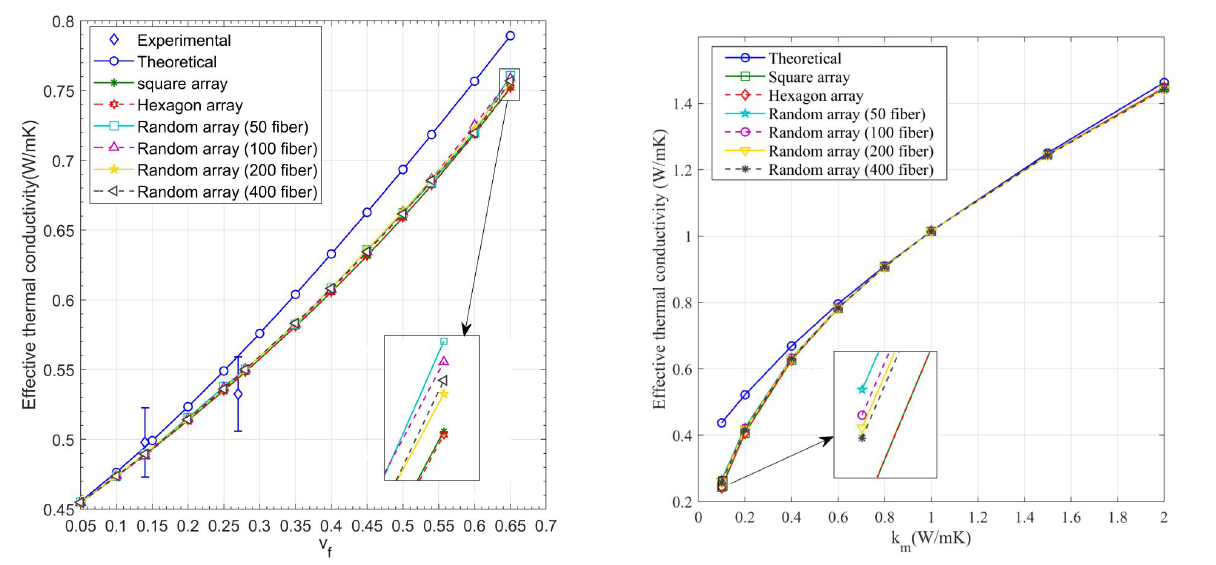
Figure 15: Effective thermal conductivity of composite in terms of the matrix thermal conductivity